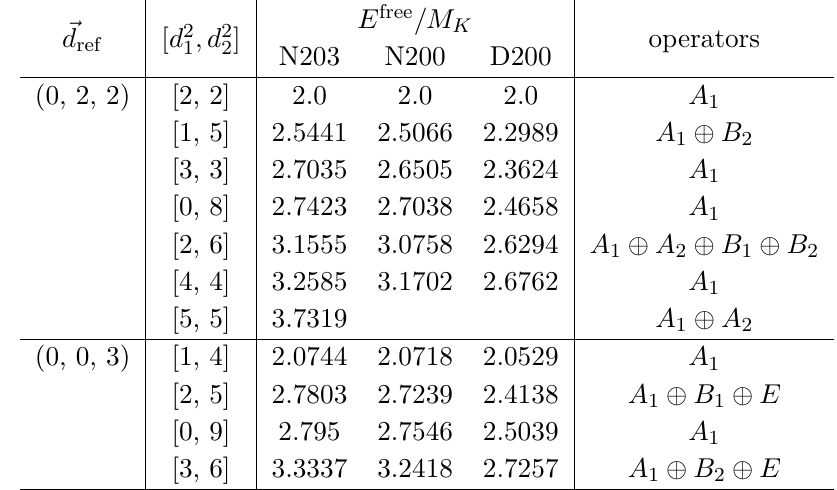
Table 31. Same as table 21 except for the two-kaon operators with 8 ≤ ~d 2